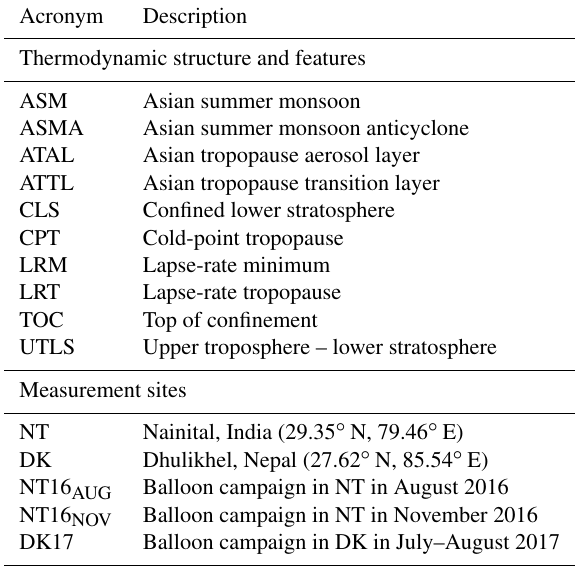
Table 1. List of the main acronyms used in this